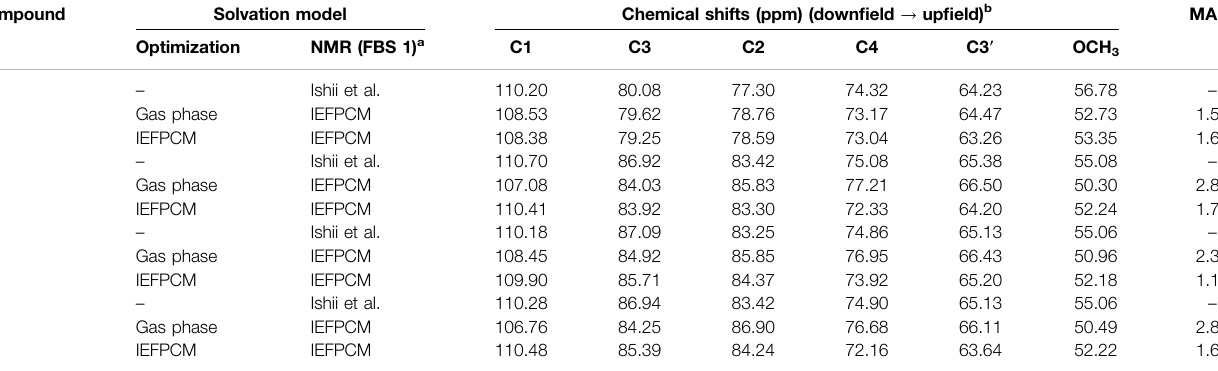
TABLE 2 | 13 C shifts for compounds 1 – 4 from Ishii and Ono (1999) compared to the computationally predicted shifts using either gas phase or implicit solvation (IEFPCM). Compound